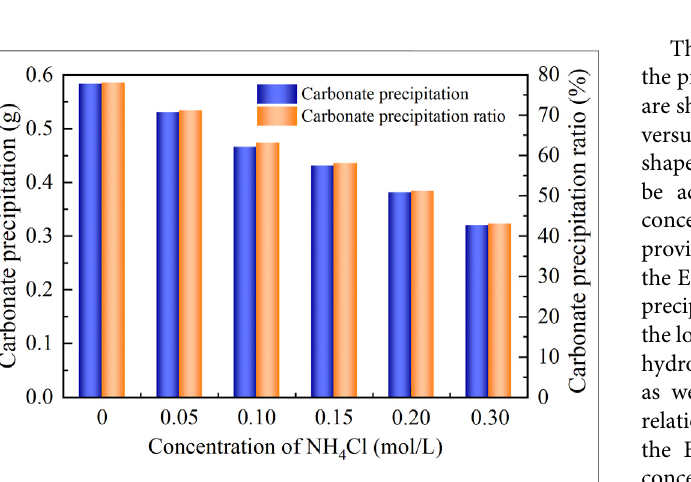
FIGURE 7 | Relations of the actual mass of carbonate precipitation and the precipitation ratio (PR) versus the NH 4 Cl concentration in the modi fi ed EICP